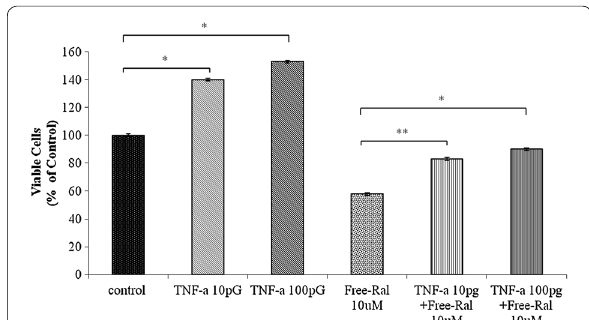
Fig. 2 Average MCF7 cell number following 72 h of TNF-α, free-Ral and combination of both. All data are expressed as mean * denotes p 0.05 and ** denotes p ≤